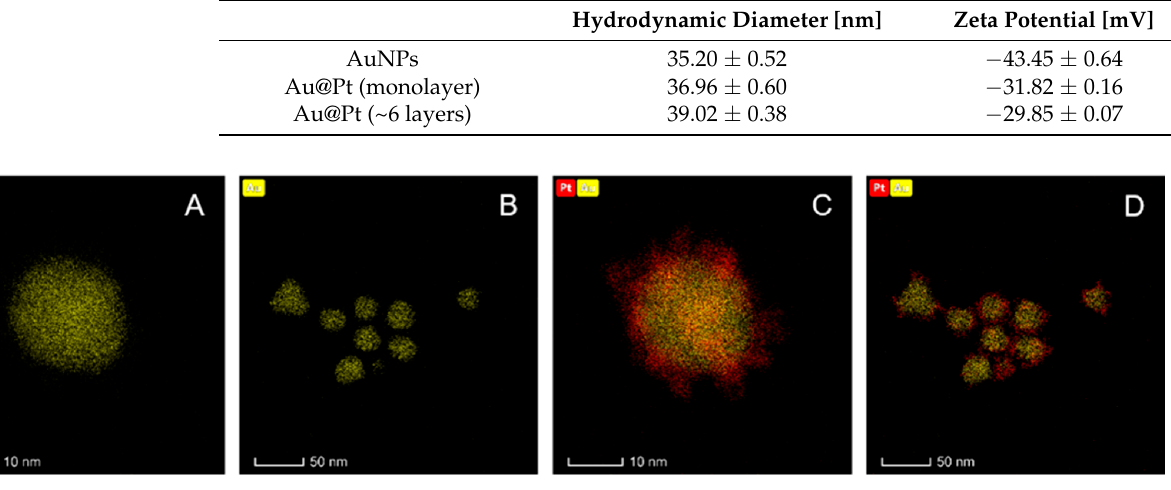
Figure 1. HR-TEM images for AuNP ( A , B ) and Au@PtNP ( C , D ).